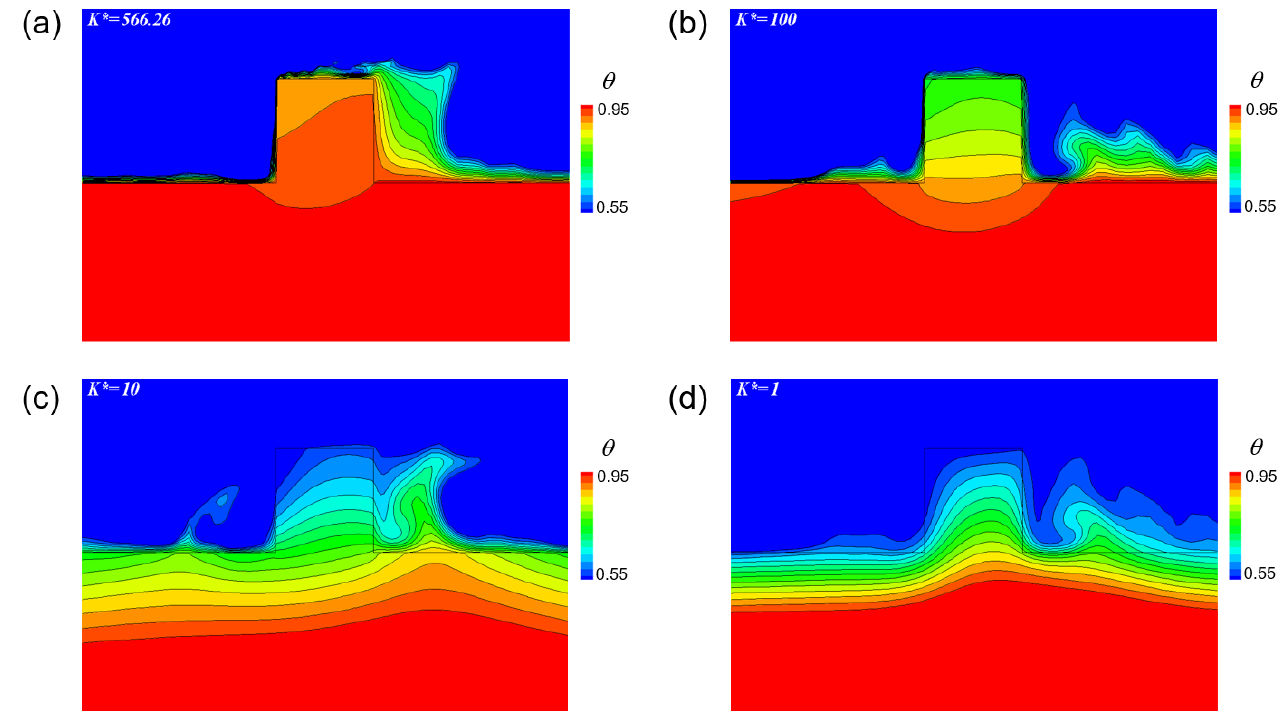
Figure 9. Instantaneous thermal fields near the rib for ( a ) K* = 566.26, ( b ) K* = 100.00, ( c ) K* = 10.00, and ( d ) K* = 1.00.